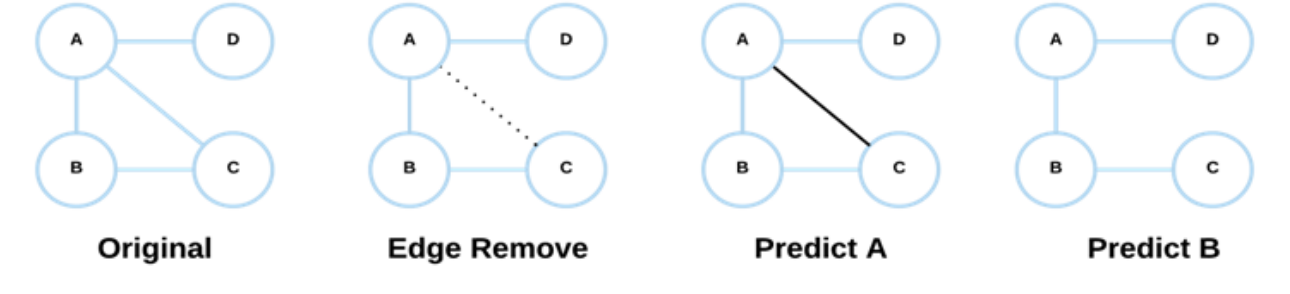
Figure 6. Accuracy Measure